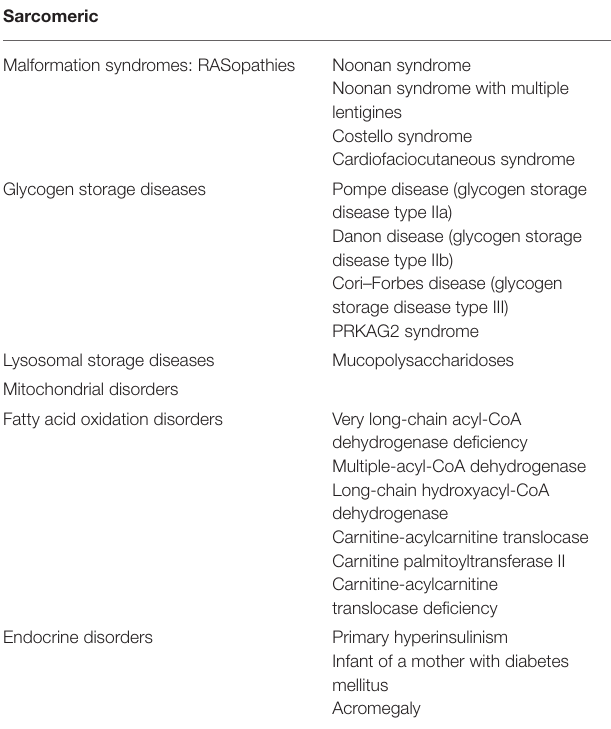
TABLE 1 | Causes of hypertrophic cardiomyopathy in children.